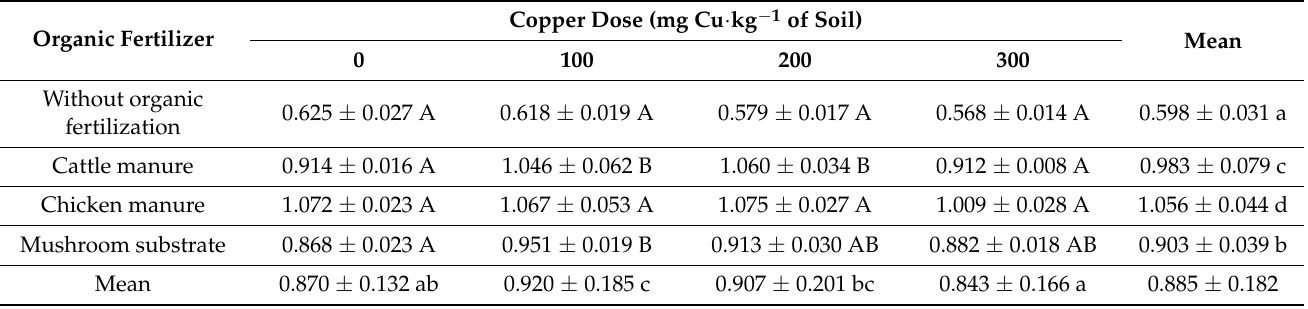
Table 4. Total nitrogen uptake by cocksfoot in three years, g N · pot − 1 (mean ± SD).